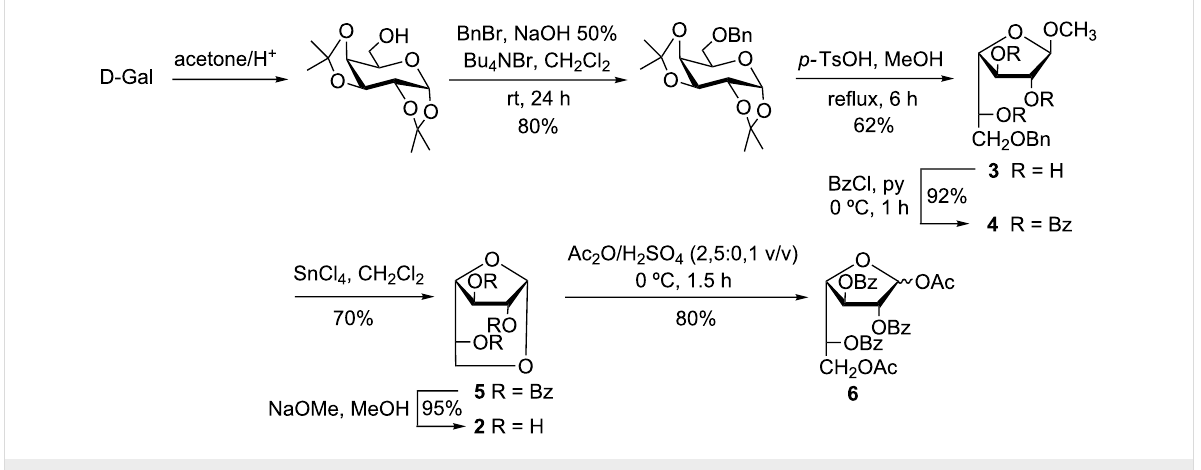
Scheme 1: Reported synthesis of 1,6-anhydro- α -D-galactofuranose [16,17].